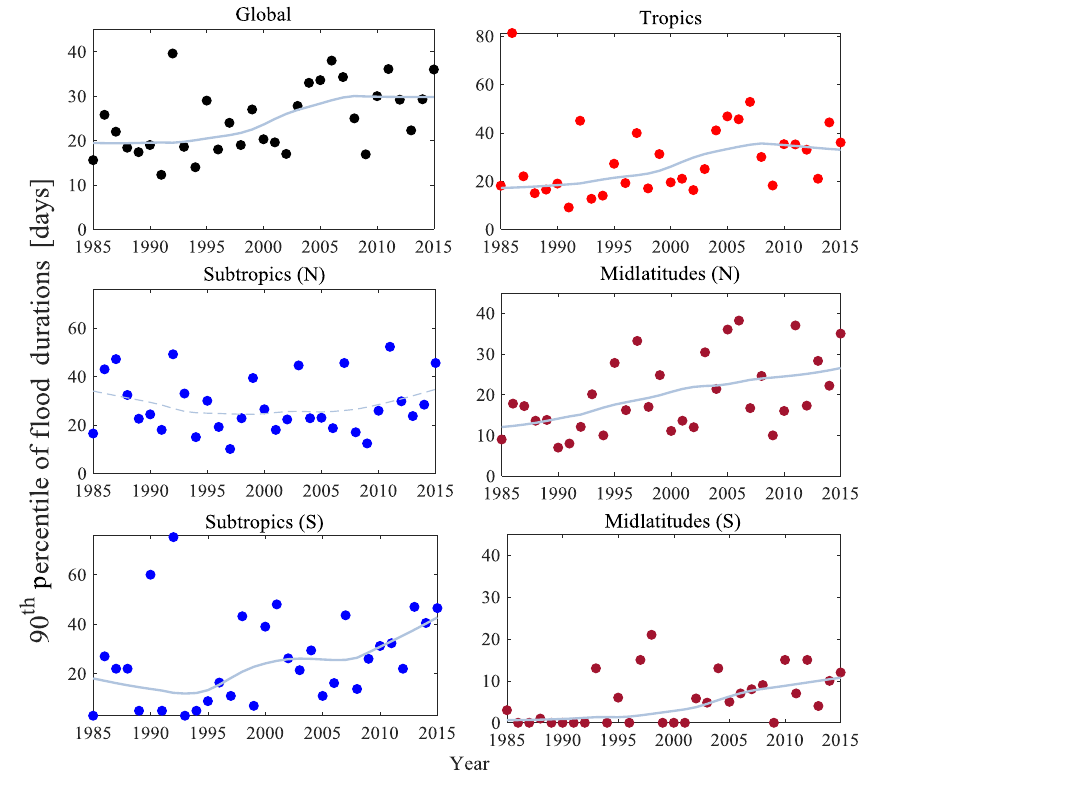
Figure 6. Same as Fig. 2 but for the 90th percentile of flood durations.